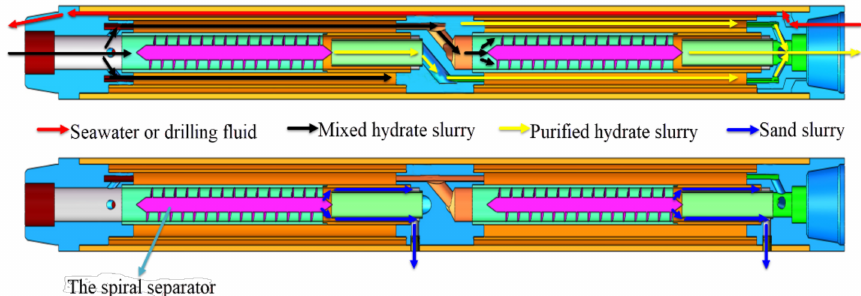
Figure 3. Schematic diagram of fluid flow direction of the downhole spiral separator.